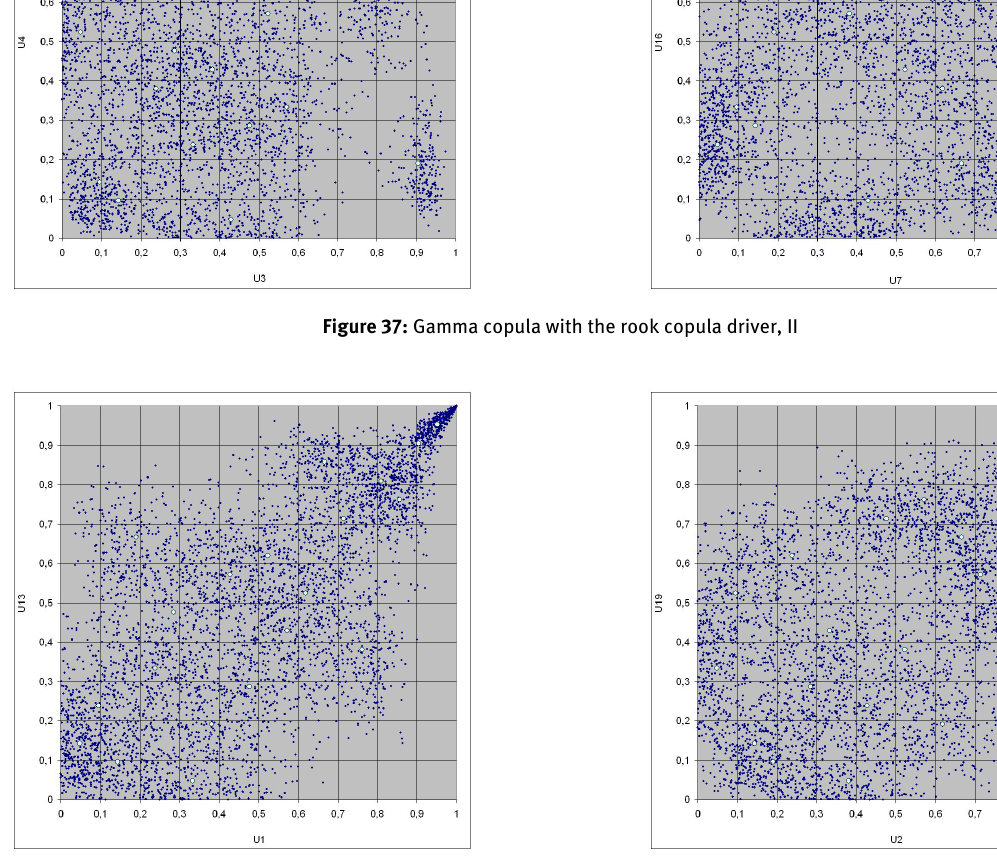
Figure 38: Gamma copula with UF copula driver,